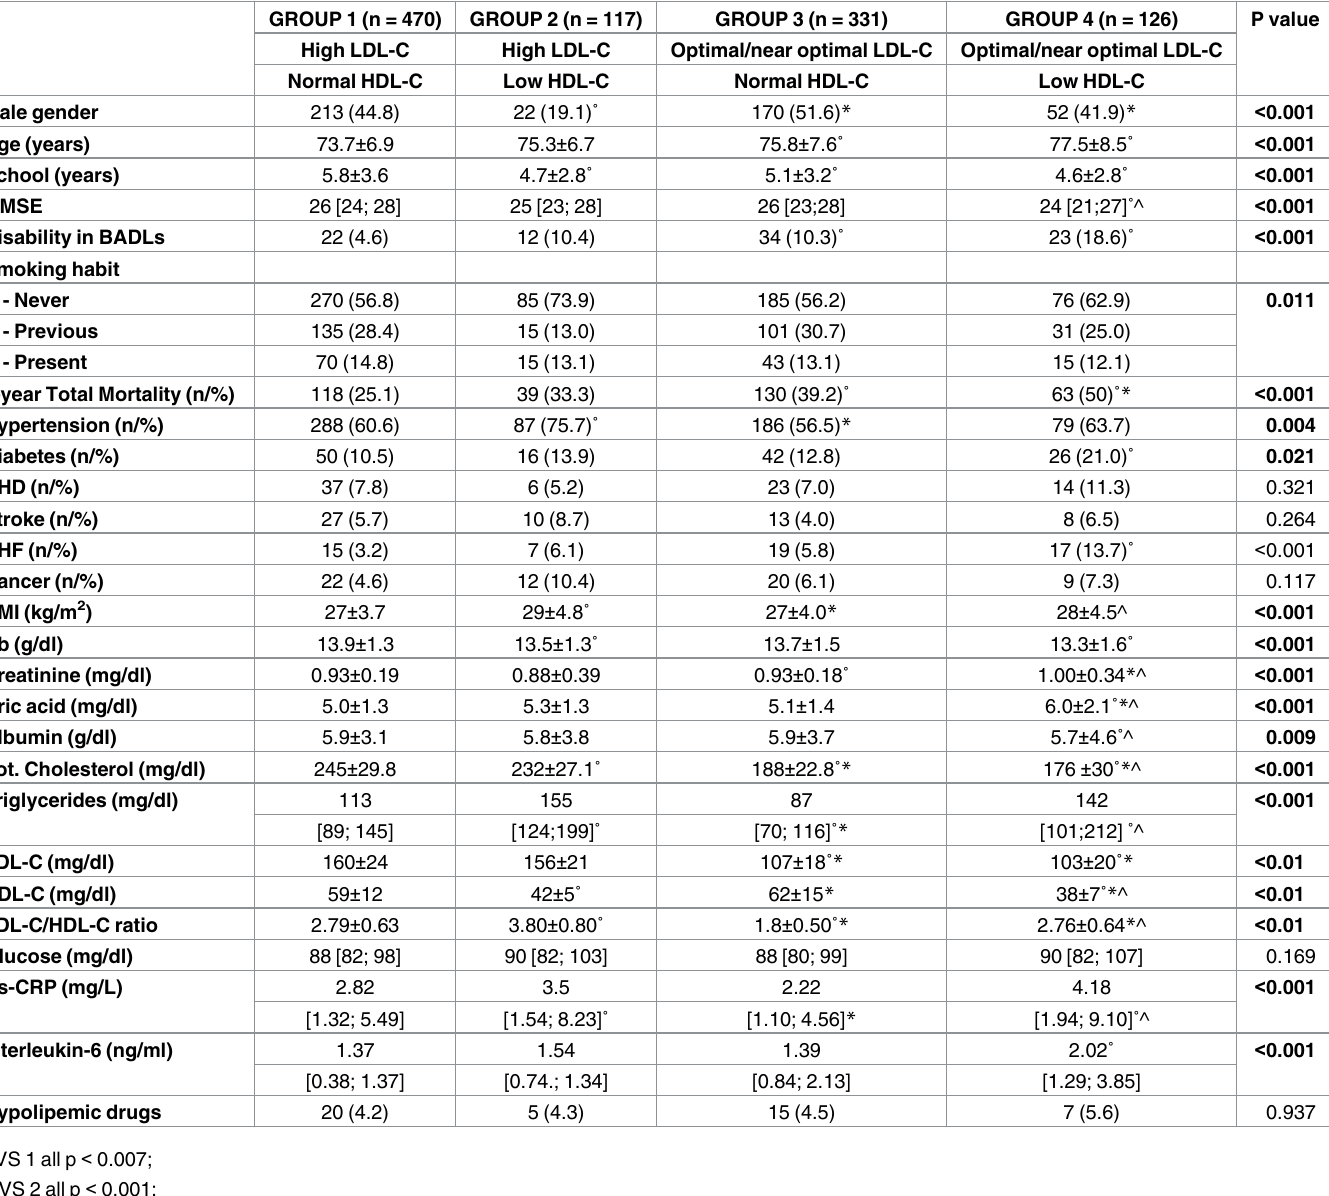
Table 1. Principal characteristics of 1044 community dwelling older individuals enrolled into the INCHIANTI study according to combined levels of LDL-C and HDL-C (LDL-C cut off: 130 mg/dl; HDL-C cut off: 40 mg/dl males, 50 mg/dl